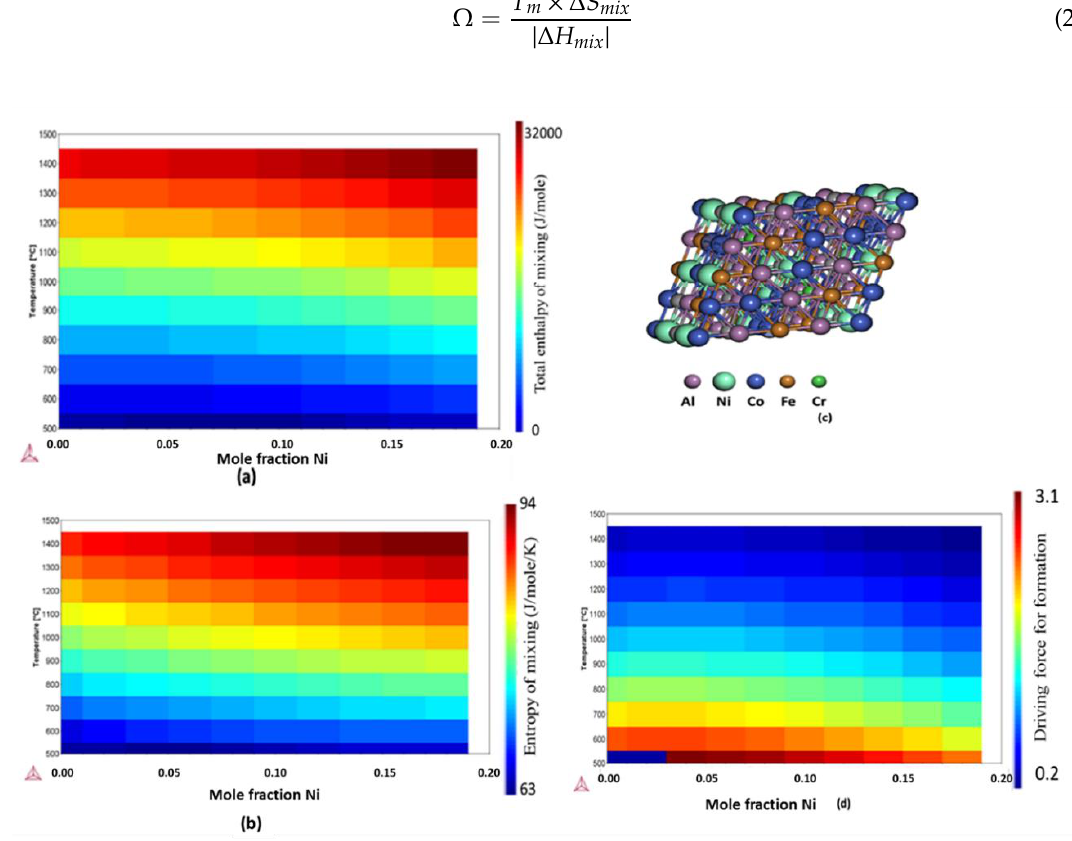
Figure 3. Role of Ni on the thermodynamic stability of HEA AlCoCrFeNi ( a ) Total enthalpy of mixing (J / mole) ( b ) Entropy of mixing (J / mole / K) ( c ) Optimized BCC lattice ( d ) Driving force for formation of B2_BCC per mole of AlCoCrFeNi.